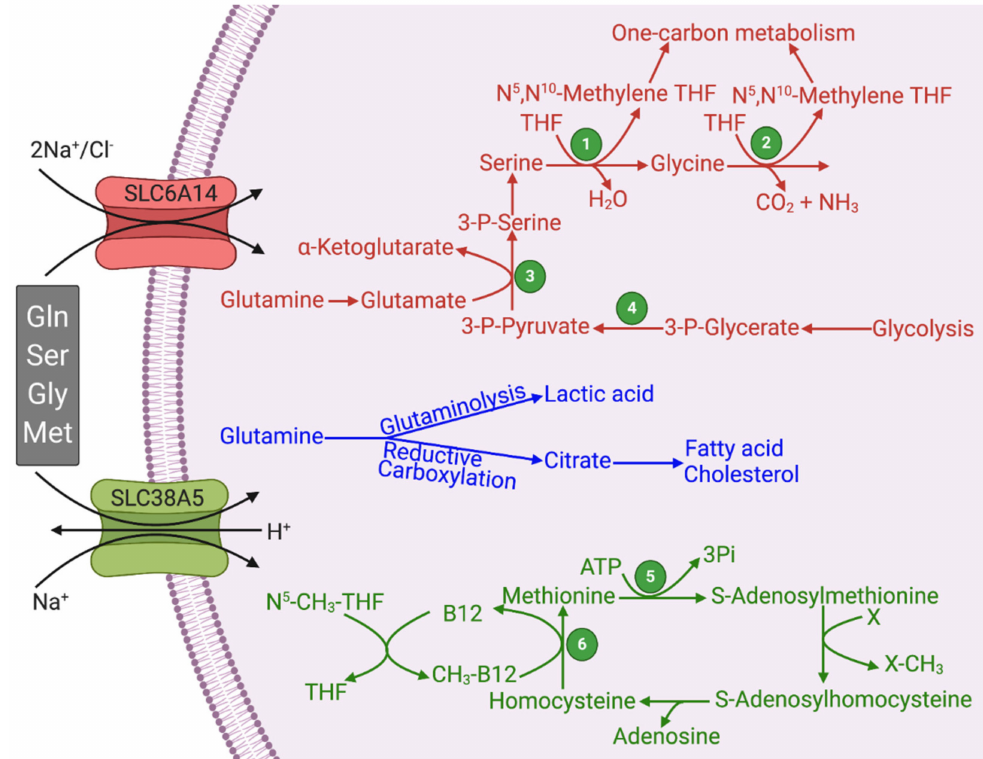
Figure 2. Functional features of SLC6A14 and SLC38A5 and their relevance to glutaminolysis and serine–glycine–one- carbon pathway. Figure legend 1, Serine hydroxymethyl transferase (SHMT); 2, Glycine cleavage system; 3, Phosphoserine aminotransferase (PSAT); 4, Phosphoglycerate dehydrogenase (PHGDH); 5, Methionine synthase; THF,